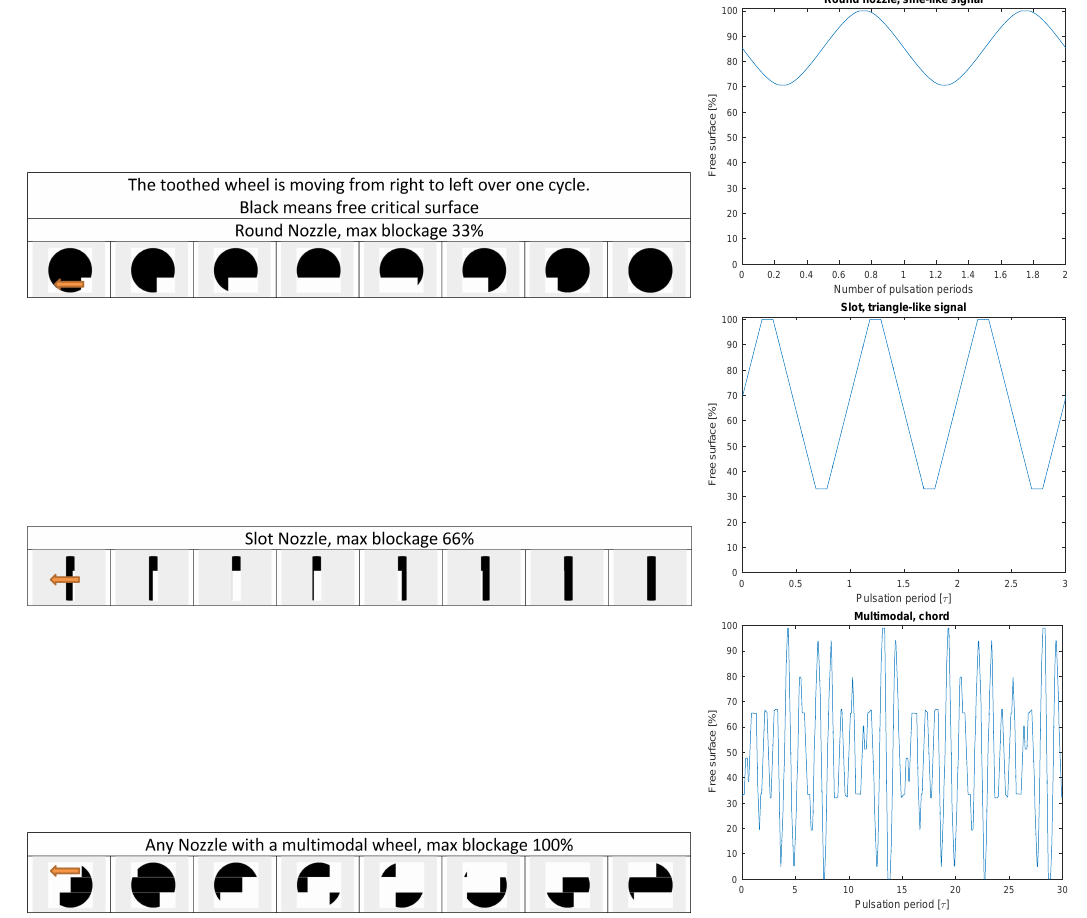
Figure 11. Module “Eclipse” for the calculation of the pulsation pattern. ( Top ): Sine-like signal with a round nozzle at 33% coverage. ( Middle ): Saw-like modulation with a quarter-round slot at 66% coverage. ( Bottom ): Multimodal wheel (major